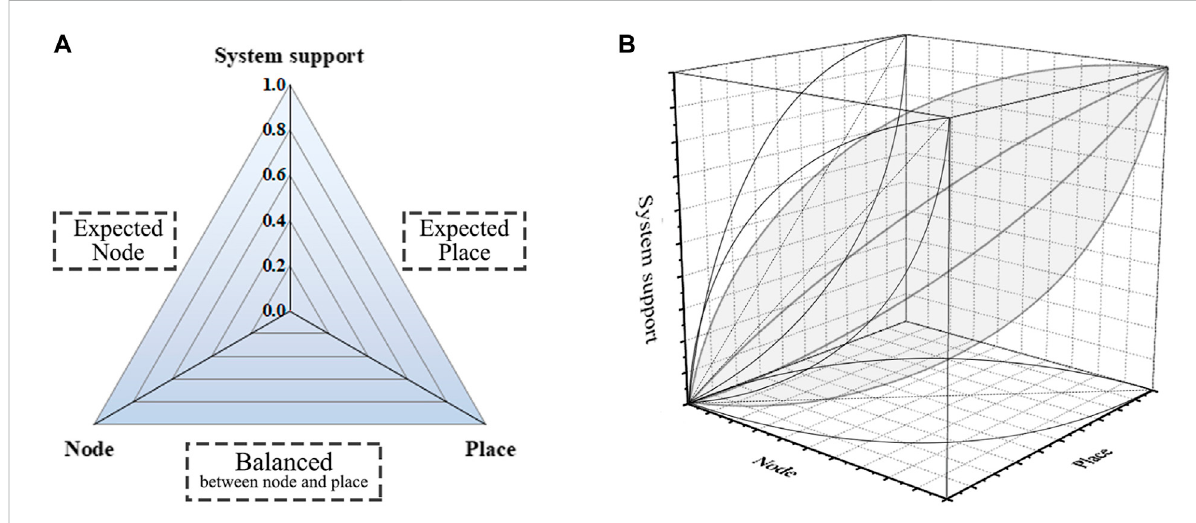
FIGURE 3 Illustrations of the node-place-system support model. (A) overall structure (B) model illustration.